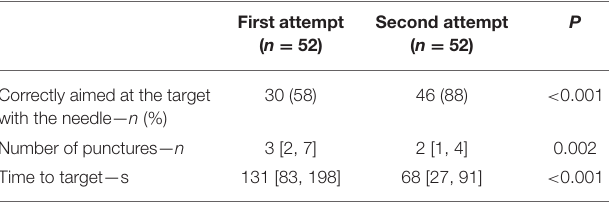
TABLE 2 | Performance of the first and second attempts at the BlockSim in the overall resident population. First attempt ( n =